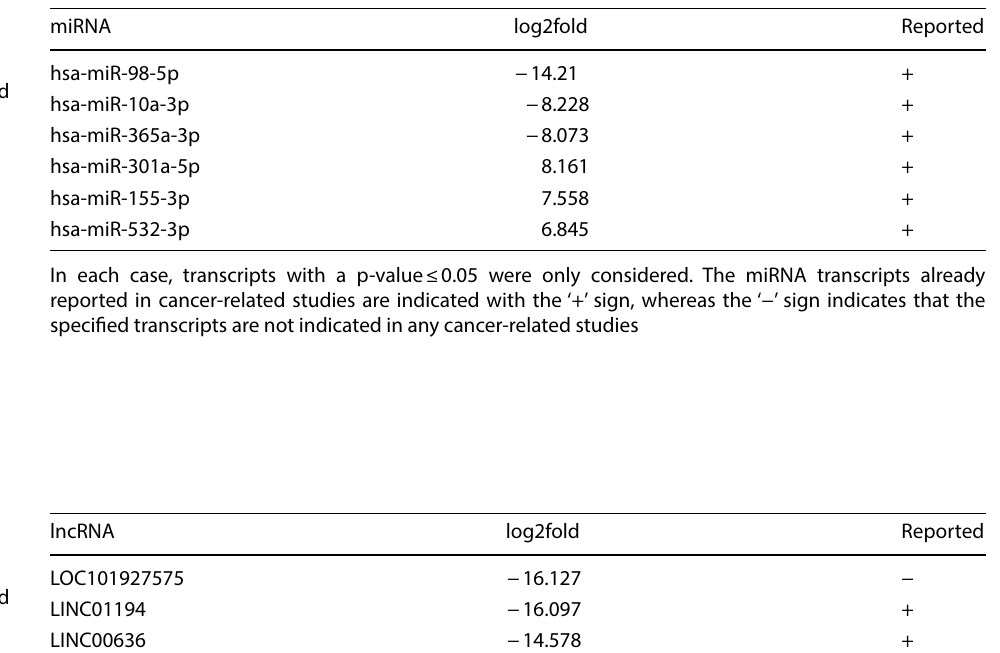
Table 3 Top three downregulated and upregulated miRNA transcripts in OS-P compared to OS cells